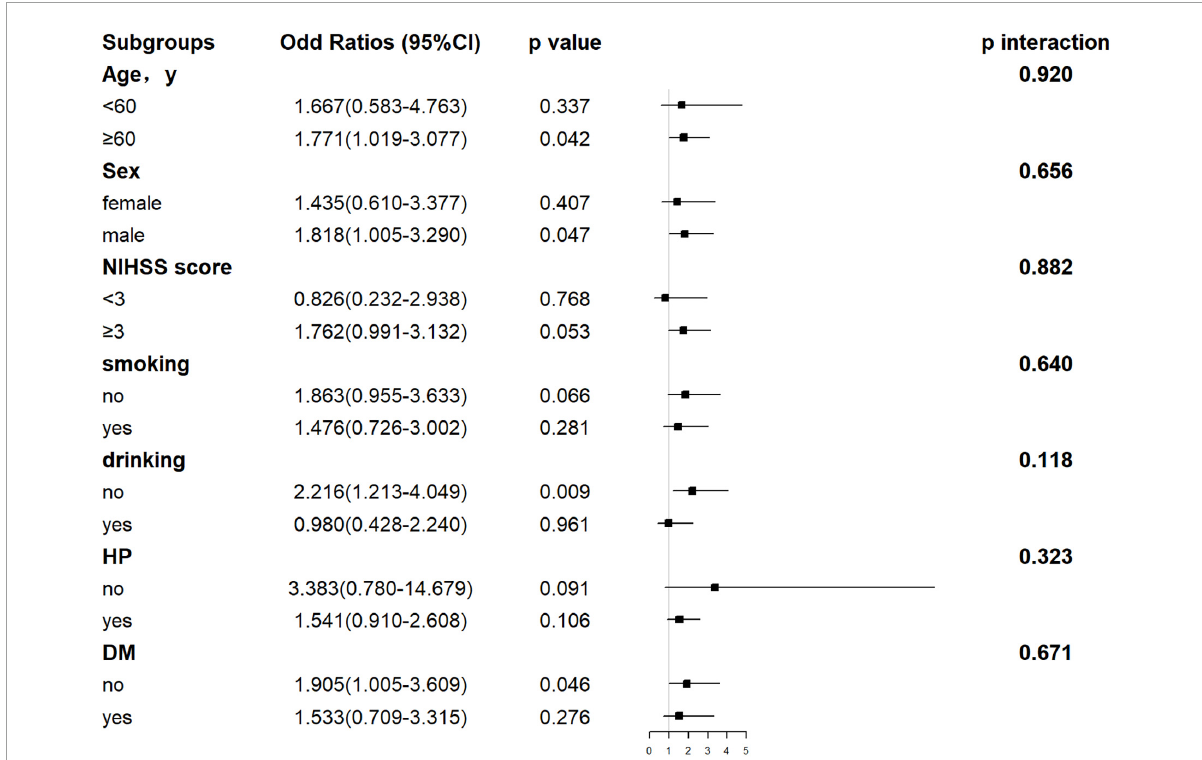
FIGURE6 Forest plot of subgroup analysis for the association between AST levels and functional outcome at 1 year. The AST becomes a dichotomous variable with the optimal cutoff value determined according to Youden’s index of the ROC curve. It is divided into < 22.50 and ≥ 22.50 U/l. NIHSS, National Institutes of Health Stroke Scale; HP, hypertension; DM, diabetes mellitus; AST, aspartate